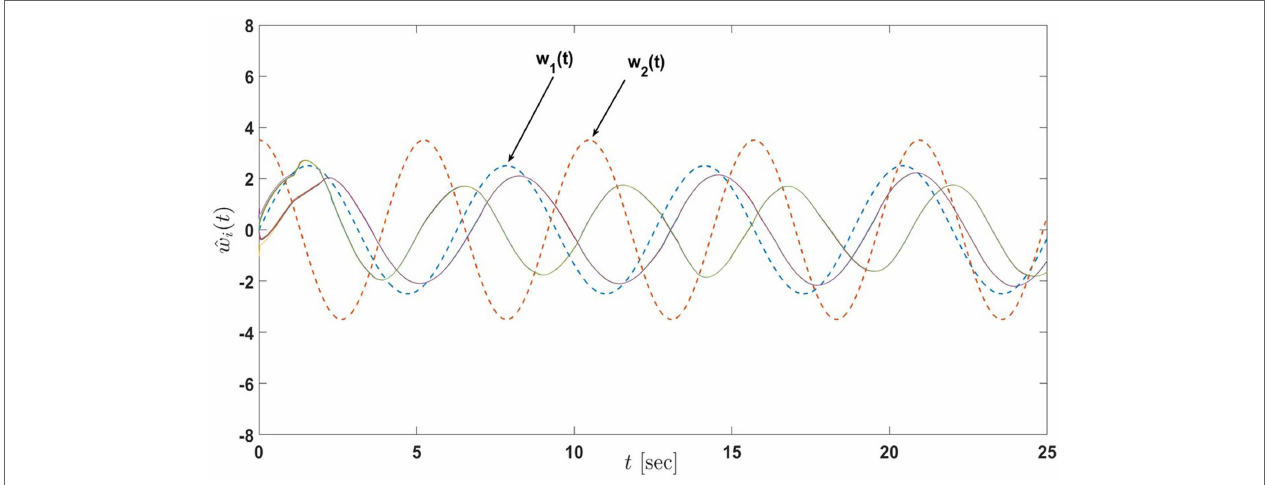
FIGURE 17 | Input estimates of the active-passive sensor network in Example 4 with 12 nodes under the proposed architecture equations (58) and (59) with the decrease in (cid:27) i , i = 1, :::; 12 (the dash lines denote the inputs of the actual process and the solid lines denote the input estimates of nodes).